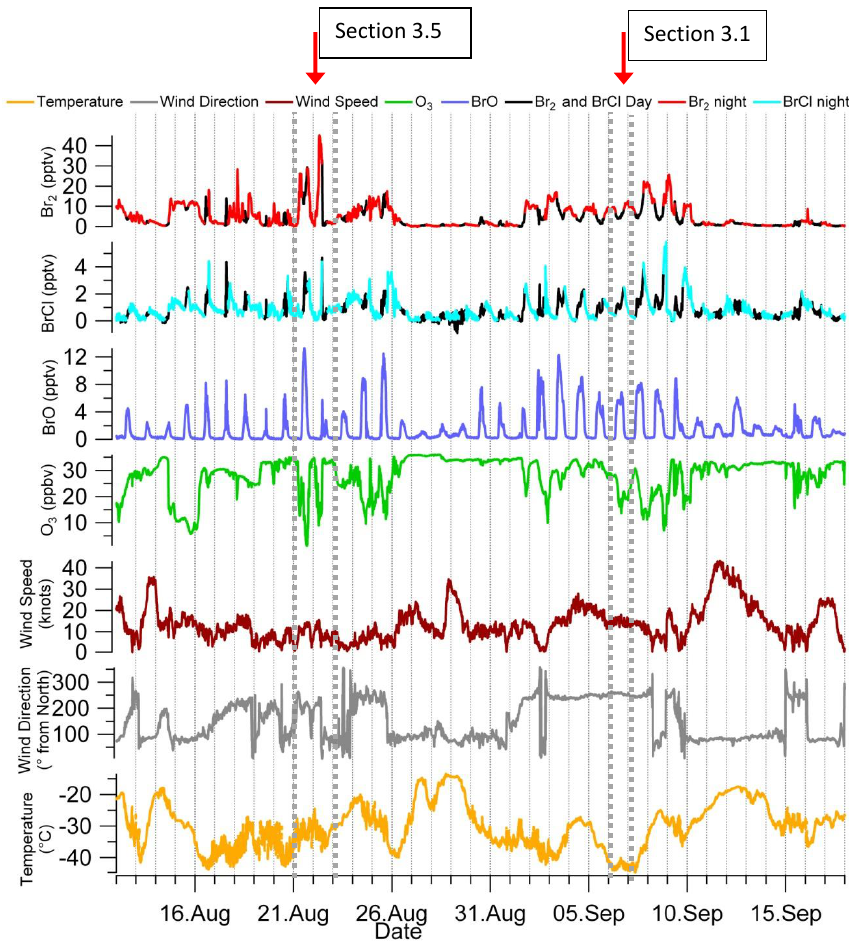
Fig. 4. Overview of measurements at Halley from 12 August to 18 September 2007. Br 2 , BrCl and BrO are shown as 10min averages; for Br 2 and BrCl, daytime observations are coloured black. Also shown are surface O 3 (10min averages), local wind speed and direction, and local